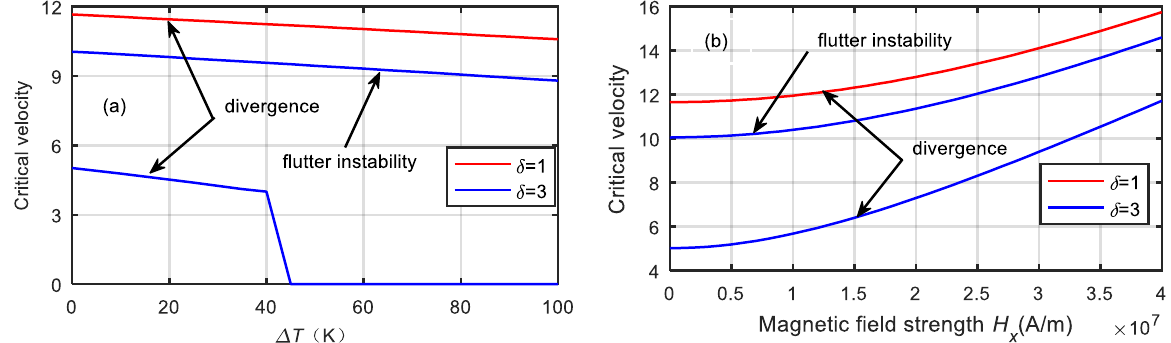
Figure 9. Critical velocity variations of microtube with temperature difference and magnetic field strength. ( a ) temperature difference. ( b ) magnetic field strength.